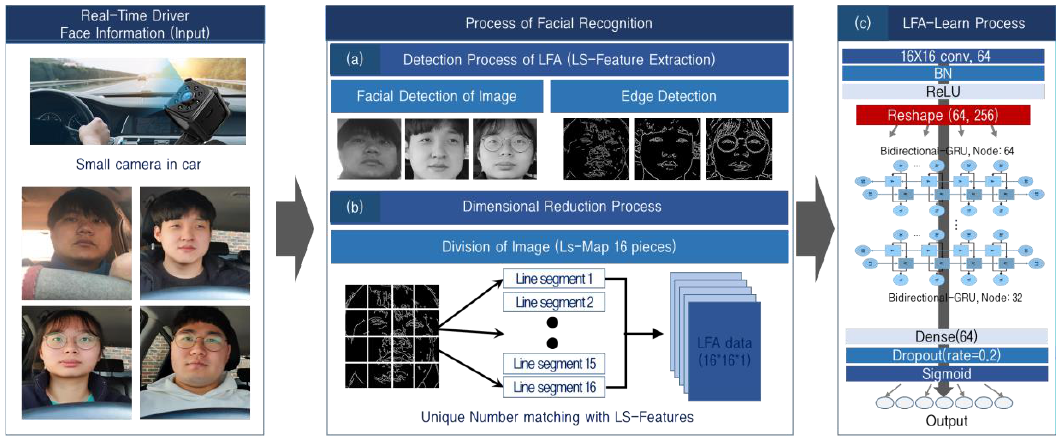
Figure 2. Line-segment feature analysis-convolutional recurrent neural network ( LFA-CRNN)-based facial expression analysis for driver health risk assessment.